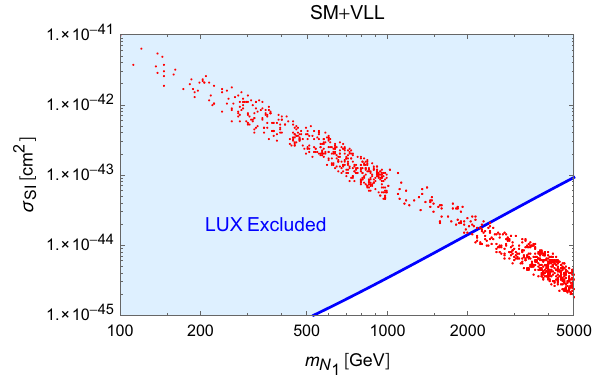
Fig. 2 Model points satisfying EWPT and Higgs width constraints and providing the correct DM relic density (see main text for clarifica- tion) reported in the bidimensional plane ( m N is excluded by current constraints from DM direct